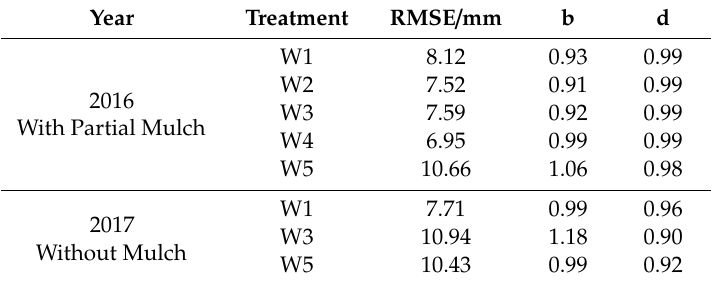
Table 4. Statistics of observed and estimated evapotranspiration in 2016 and 2017 on partial mulched and non-mulched plots in Xinjiang, China.